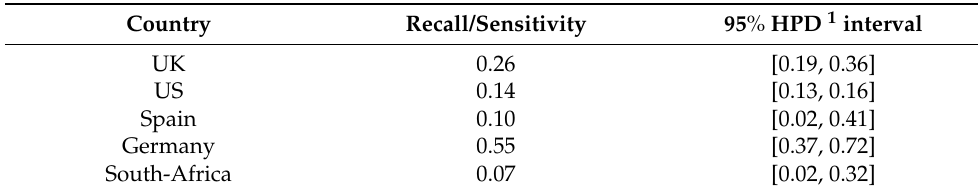
Table 4. Results—Insurance claims fraud